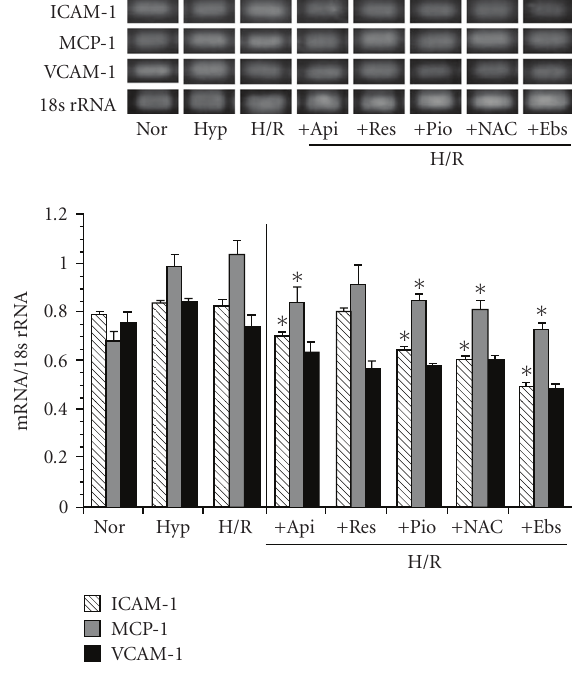
∗∗ ∗∗ ∗ Figure 7: The e ff ects of H/R on the expression levels of adhesion molecules in astrocytes isolated from SHRSP/IZM and a compar- Figure 6: The e ff ects of H/R on the expression levels of adhesion ison of the inhibitory e ff ects of apigenin and resveratrol, ebselen, molecules in astrocytes isolated from SHRSP and a comparison NAC, and pioglitazone. The astrocytes isolated from SHRSP/IZM between the inhibitory e ff ects of apigenin, resveratrol. The astro- were incubated under hypoxia (1% O2, 24 hour) or hypoxia + cytes isolated from SHRSP/IZM was incubated under hypoxia (1% reoxygenation (21% O2, 3 hour) as previously described [13, 15]. O2, 24 hour) or hypoxia + reoxygenation (21% O2, 3 hour) as They were incubated for an additional period either before or previously described [13, 15]. They were incubated for an additional after the hypoxia with 50 μ M of apigenin, resveratrol, ebselen, period either before hypoxia or after hypoxia with 50 μ M of NAC, or pioglitazone. The ICAM-1, MCP-1, and VCAM-1 mRNA apigenin or resveratrol. The ICAM-1, MCP-1, and VCAM-1 mRNA measurements were carried out as described in Figure 1 and in measurements were carried out as described in Figure 1 and in the text. The bars represent the mean ± SD ( n = 4). Asterisk ( ∗ ): the text. The bars represent the mean ± SD ( n = 4). Asterisk ( ∗ ): P < . 05 compared with the normal condition values. Nor: normal P < . 05 compared with the normal condition values. Nor: normal conditions; Hyp: Hypoxia; H/R: hypoxia and condition; Hyp: Hypoxia; H/R: hypoxia and reoxygenation.